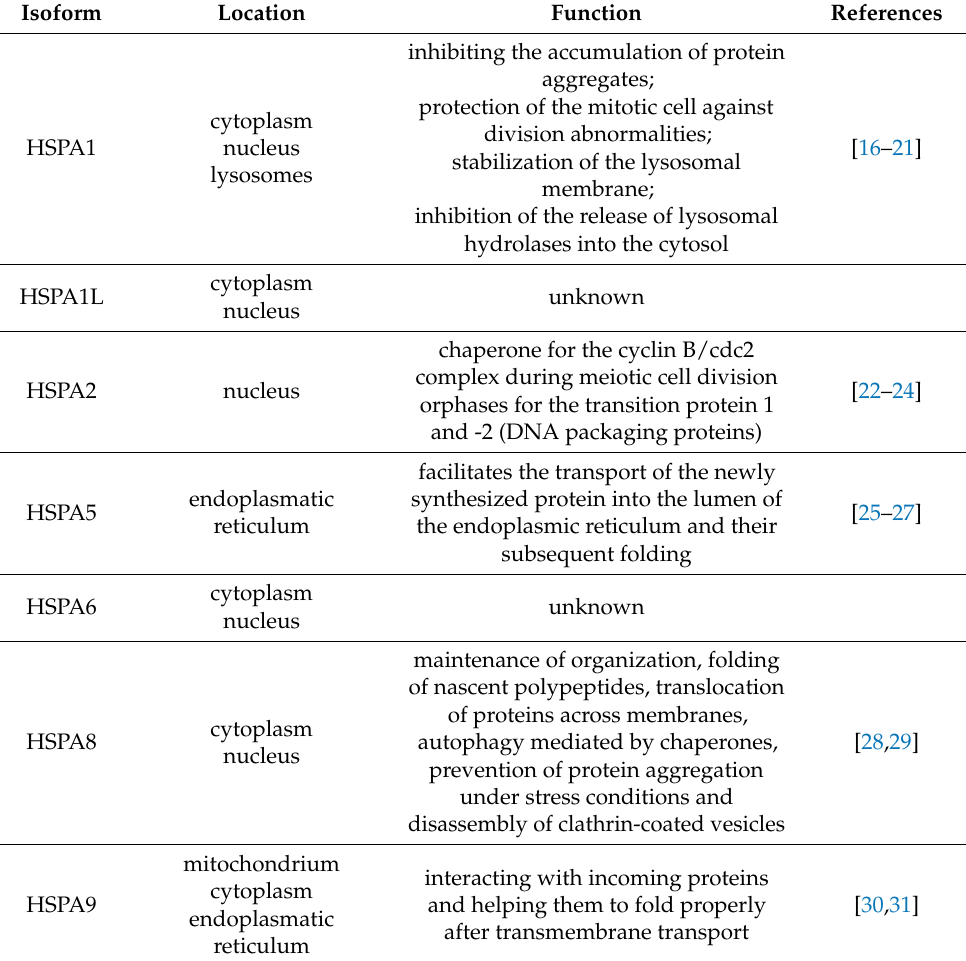
Table 1. HSP70 isoform